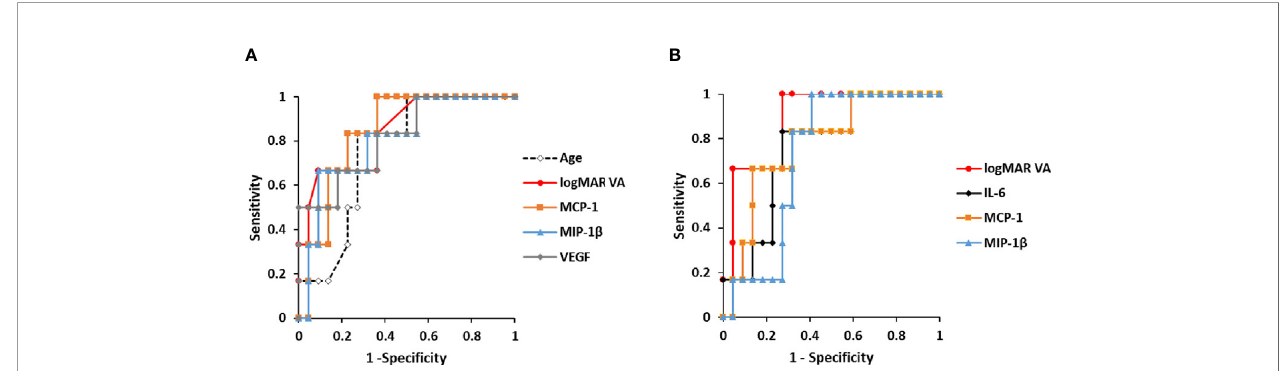
FIGURE 4 | Predictive factors for the incidence of macular atrophy in nAMD eyes under a fl ibercept treatment. (A) ROC curves of age, pre-IVA logMAR VA, and pre-IVA levels of MCP-1, MIP-1 b , and VEGF are shown as predictive factors for MA incidence in nAMD eyes under IVA treatment for 2 years. (B) ROC curves of post-IVA logMAR VA and post-IVA levels of IL-6, MCP-1, and MIP-1 b are presented. Cutoff value is de fi ned by closest point to upper left-hand corner of graph. IL, interleukin; IVA, intravitreal injection of a fl ibercept; MA, macular atrophy; logMAR, logarithm of the minimum angle of resolution; MCP-1, monocyte chemotactic protein-1; MIP-1 b , macrophage in fl ammatory protein; nAMD, neovascular age-related macular degeneration; ROC, receiver operating characteristic; VEGF, vascular endothelial growth factor.